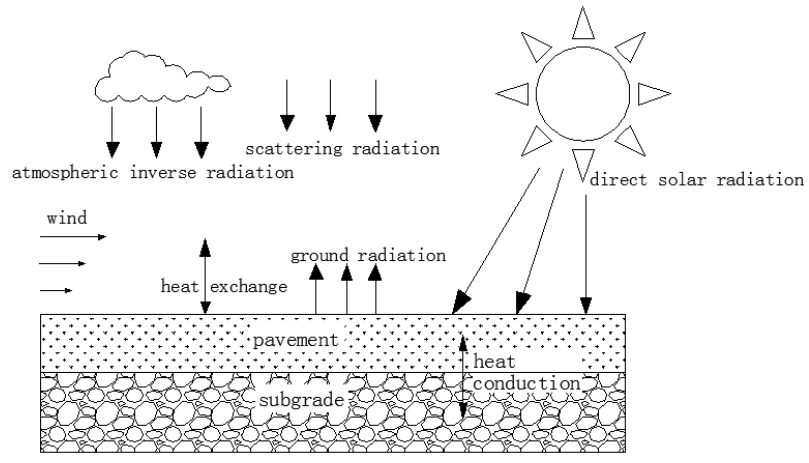
Figure 1. Schematic diagram illustrating the heat exchange process in asphalt pavement.